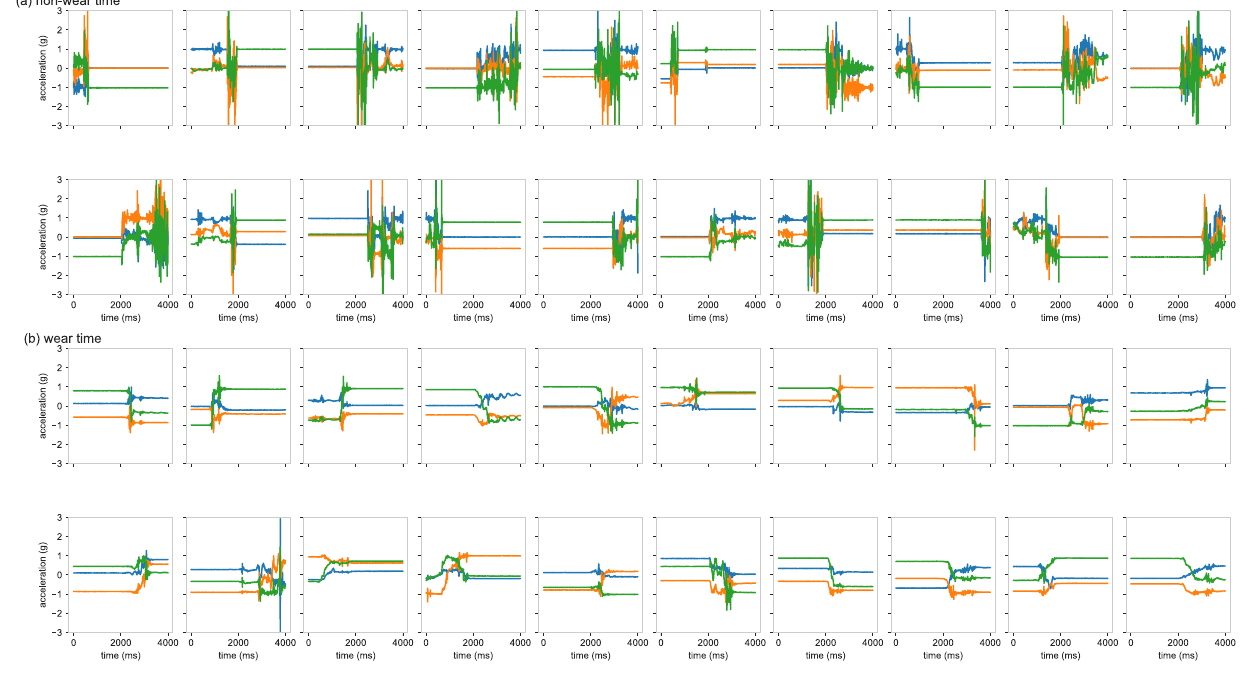
Figure 1. Start or the stop segments of candidate non-wear episodes where features of a length of 2–10 s were extracted; ( a ) start or stop episodes of true non-wear time, ( b ) start or stop episodes of wear we extracted a segment or window of raw triaxial acceleration data right before (i.e. preceding) and right after (i.e. following) a candidate non-wear episode, and used the raw triaxial acceleration data as features. Different features were created by varying the window size from 2–10 s, since the optimal window size was unknown at that point. Technically, a preceding feature is extracted from t start − w up to t start , where t start is the start timestamp of the episode in seconds and w is the window size in seconds. The following feature is extracted from t stop until t stop + w , with t stop marking the end of an episode; for example, a preceding feature with a 5-s window would yield a (100 Hz × 5 s) by (3 axes) = (500 × 3) matrix. In addition, by utilising our labelled gold- standard dataset, each constructed feature was either given the label 0, if it preceded or followed wear time, or 1, if it preceded or followed non-wear time; no differences were made between start and stop events. To illustrate this, Fig. 1 displays several start and stop segments from candidate non-wear episodes from where the features were extracted. Importantly, no additional filtering or pre-processing was performed on the raw data, and features belonging to the minority classes were up-sampled by random duplication so as to create a class balanced dataset. Training a deep neural network. Convolutional neural networks (CNN) are designed to process data in the form of multiple arrays 32 . CNNs are able to extract the local dependency (i.e. nearby signals that are likely to be correlated) and scale invariant (i.e. scale-invariant for different paces or frequencies) characteristics from the feature data 27 . The 1-dimensional (1D) CNN is particularly suitable for signal or sequence data such as accel- erometer data 32 and, to date, 1D CNNs have successfully been applied for human activity recognition 28,33 , and outperform classical machine learning models on a number of benchmark datasets with increased discrimina- tive power 34 . A total of four 1D CNN architectures were constructed and trained for the binary classification of our features as either belonging to true non-wear time or to wear time episodes. Figure 2 shows the four proposed architec- tures labelled V1, V2, V3, and V4. The input feature is a vector of w × 3 (i.e. three orthogonal axes), where w is the window size ranging from 2–10 s (note that a single second contains 100 datapoints for our 100Hz data). In total, 9 × 4 = 36 different CNN models were trained. CNN V1 can be considered a basic CNN with only a single convolutional layer followed by a single fully connected layer. CNN V2 and V3 contain additional convolutional layers with different kernel sizes and numbers of filters. Stacking convolutional layers enables the detection of high-level features, unlike single convolutional layers. CNN V4 contains a max pooling layer after each convolu- tional layer to merge semantically similar features while reducing the data dimensionality 32 . A CNN architecture with max pooling layers has shown varying results, from increased classification performance 33 to pooling layers interfering with the convolutional layer’s ability to learn to down sample the raw sensor data 34 . All proposed CNN architectures have a single neuron in the output layer with a sigmoid activation function for binary classification. Training was performed on 60% of the data, with 20% used for validation and another 20% used for testing. All models were trained for up to 250 epochs with the Adam optimiser 35 and a learning rate of 0.001. Loss was calculated with binary cross entropy and, additionally, early stopping was implemented to monitor the valida- tion loss with a patience of 25 epochs and restore weights of the lowest validation loss. This means that training would terminate if the validation loss did not improve for 25 epochs, and the best model weights would be